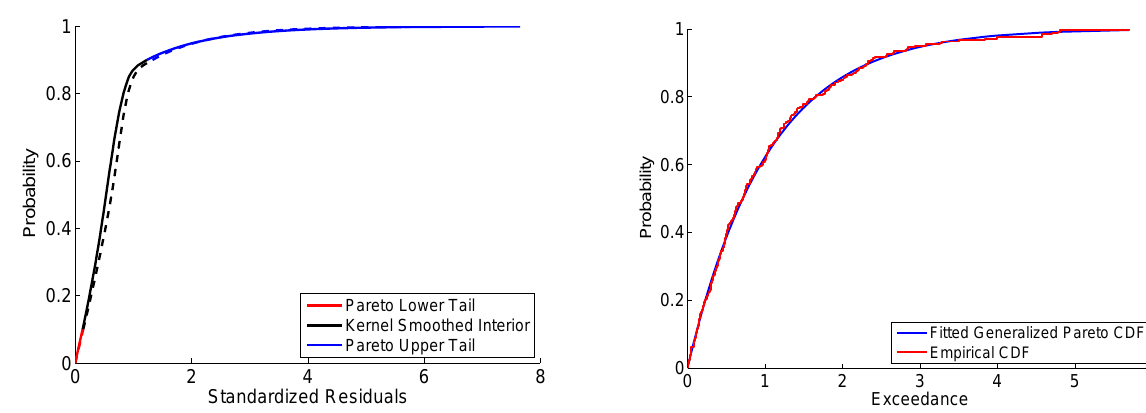
Fig. 7. Empirical and fitted exceedance probability of the upper tail of observed rainfall residuals (left), composite of the piecewise CDF of the modelled (solid lines) and observed (dashed lines) rainfall residuals at Garmisch-Partenkirchen (right).